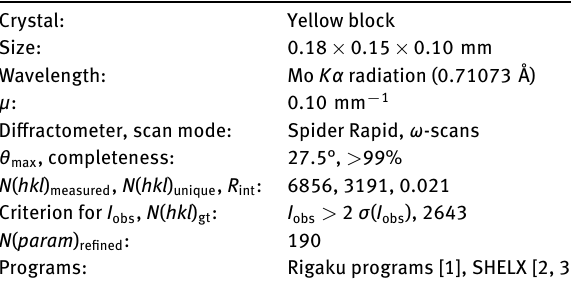
Table 1: Data collection and handling.